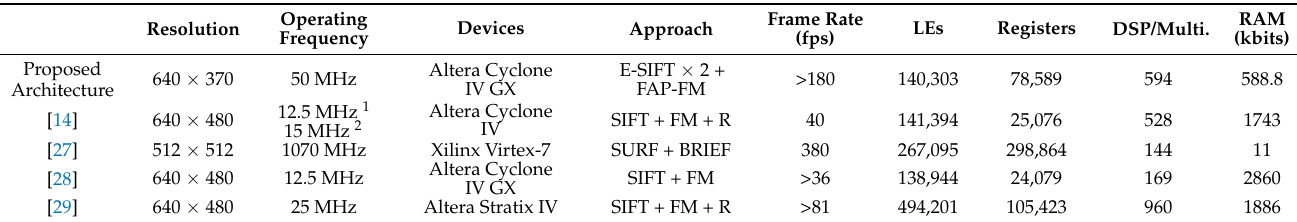
Table 6. Performance comparison of proposed stereo E-SIFTs and FAP feature matching with other published